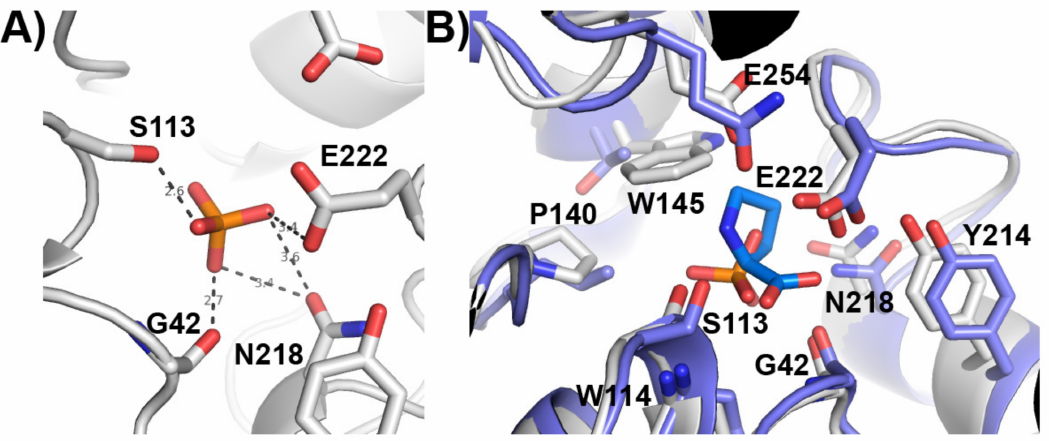
Figure 7. ( A ) Catalytic cleft of PsyPAH showing the modeled phosphate molecule. ( B ) Superposition of APF1 bound to L-Proline at the S1 site (PDB 1XRR, blue tones) and PsyPAH bound to phosphate (white tones). The numbering corresponds to PsyPAH